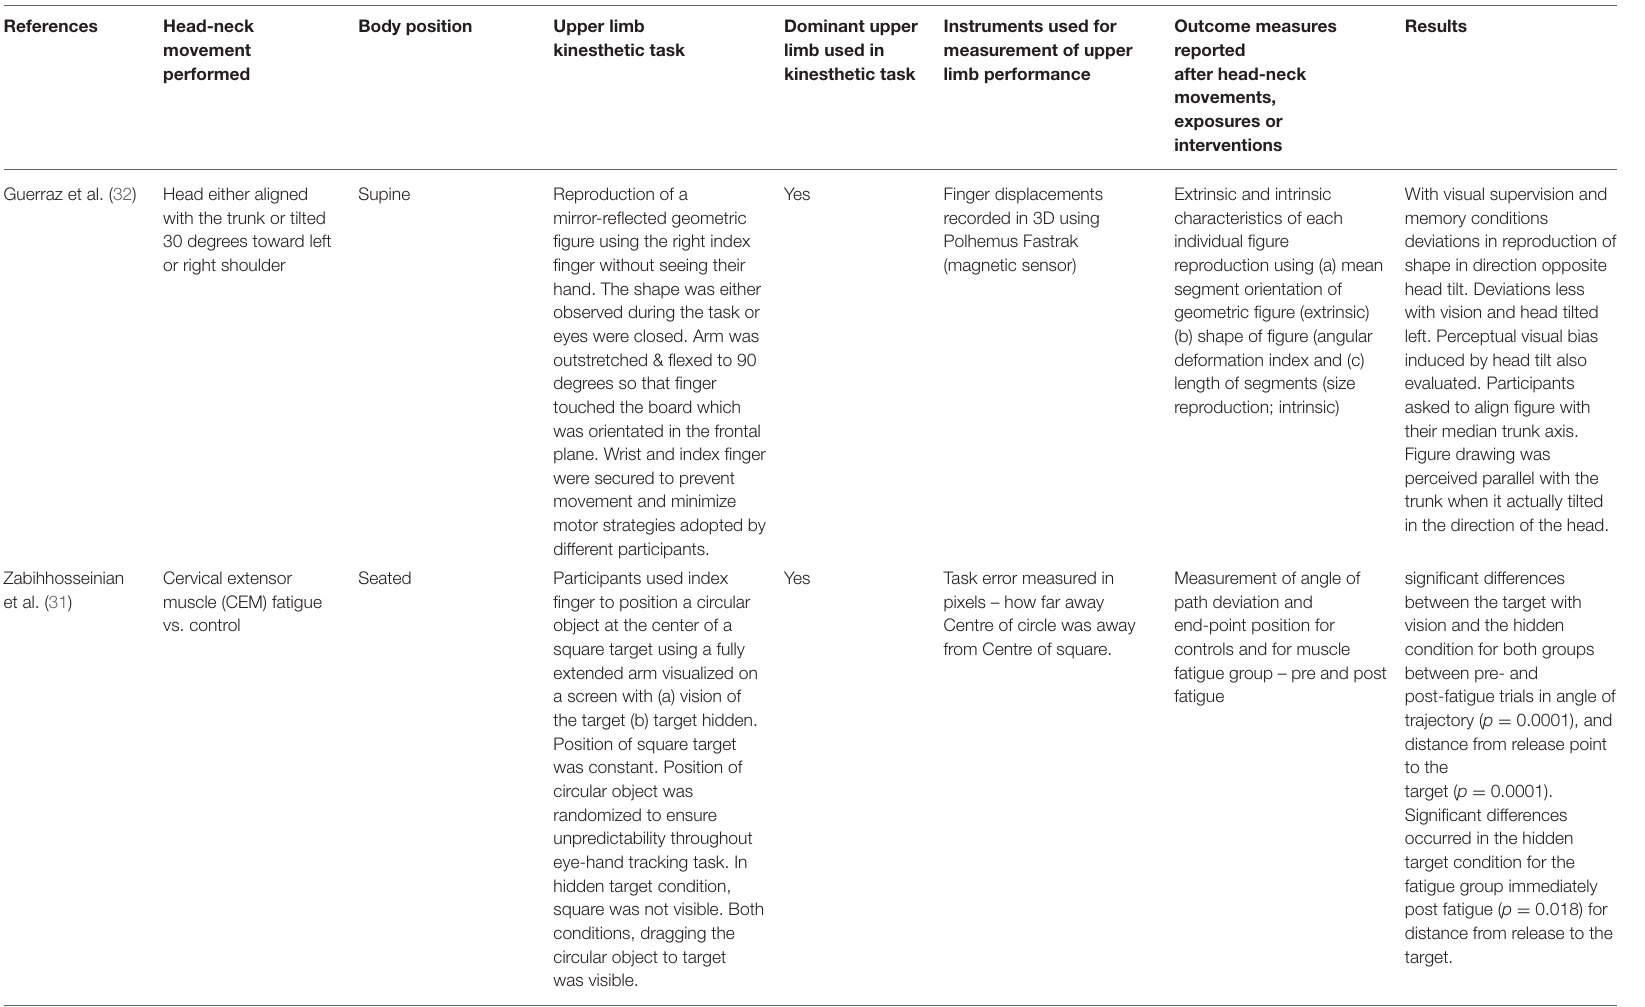
segment orientation of geometric figure (extrinsic) (b) shape of figure (angular deformation index and (c) length of segments (size reproduction; intrinsic)